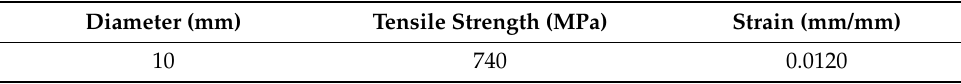
Table 8. Tensile strength and ultimate strains.